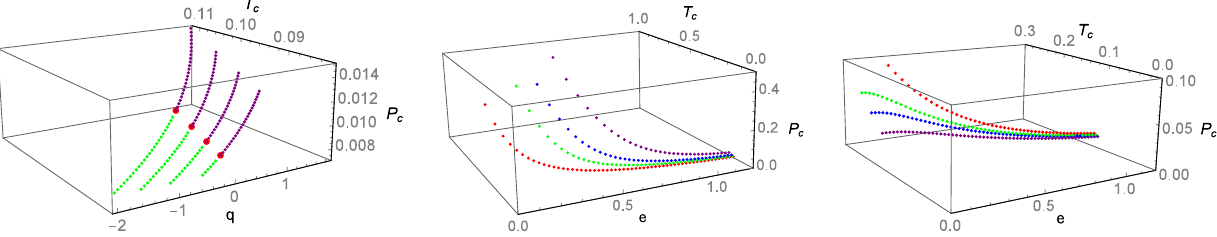
Fig. 5 The distribution of the critical points described by Eqs. (3.17) and (3.18) for different values of e and q . The left diagram corresponds to e = 1 . 90, 2 . 05, 2 . 20, and 2 . 35, respectively, from top to bottom , the green dotted curve for q < 0, the purple dotted curve for q > 0, and the